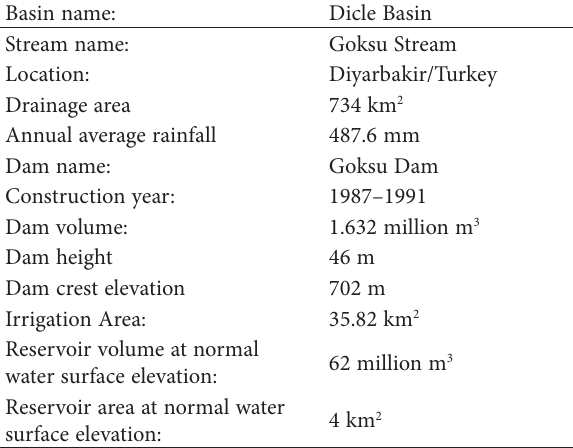
Table 1. The main characteristics of study area